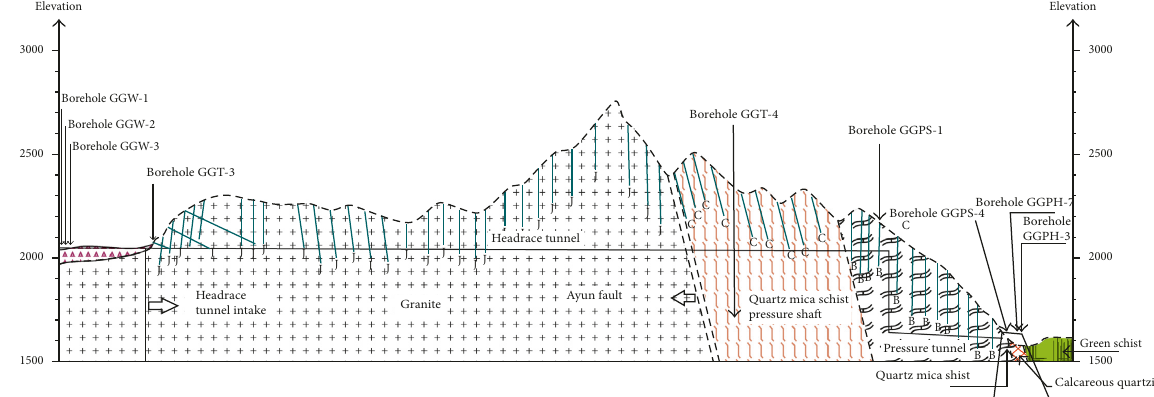
Figure 1: Geology and cross-sectional view of tunnel alignment